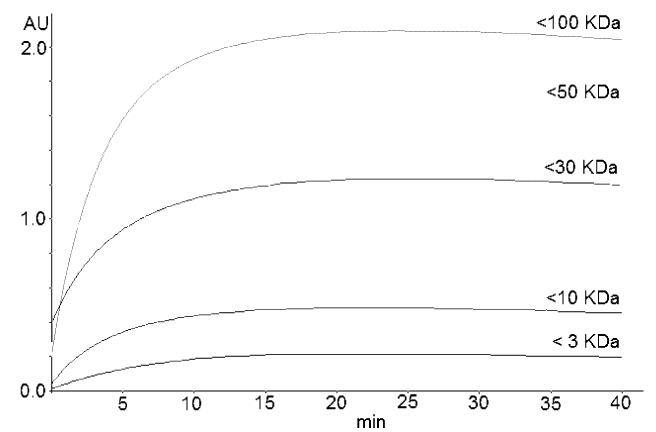
Figure 2. Kinetics of the DMAC reaction of permeates obtained by fractionating the cranberry extract A3. Permeates were obtained by molecular sieves with cut-o ff s of 3, 10, 30, 50, and 100